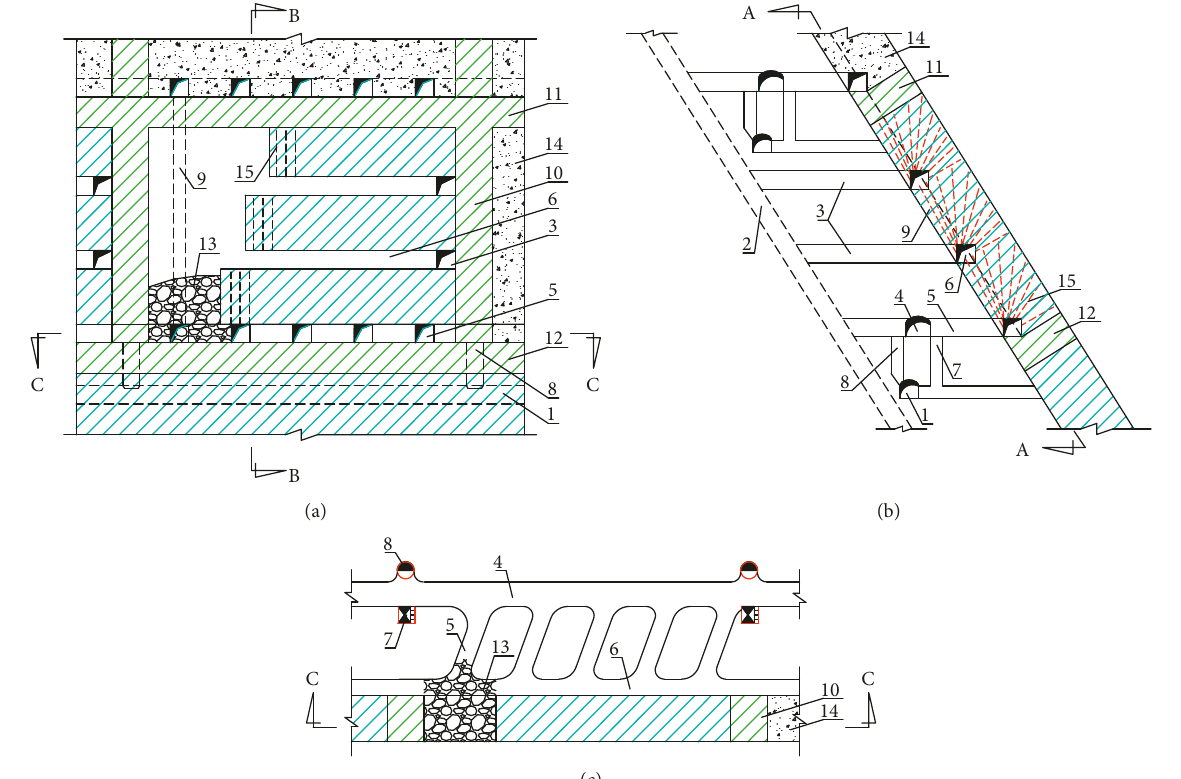
Figure 1: Sublevel drilling open-stope subsequent filling mining method.1, stage transport roadway; 2, ramp; 3, sublevel contact roadway; 4, ore-drawing roadway; 5, loading roadway; 6, rock drilling roadway; 7, pedestrian ventilation raise; 8, ore chute; 9, cutting raise; 10, intervening pillar; 11, top pillar; 12, bottom pillar; 13, ore; 14, filling body; 15, medium-deep hole. (a) A-A. (b) B–B. (c) C–C.